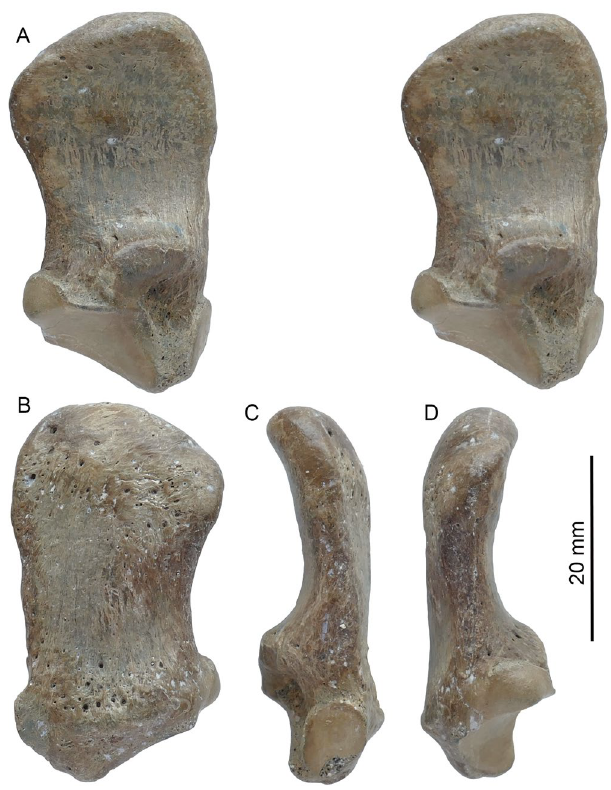
Figure 3. Ailurarctos cf. A. lufengensis , ZT-2015–0056, left radial sesamoid, ( A ) left lateral (in stereo), ( B ) medial, ( C ) proximal, and ( D ) distal